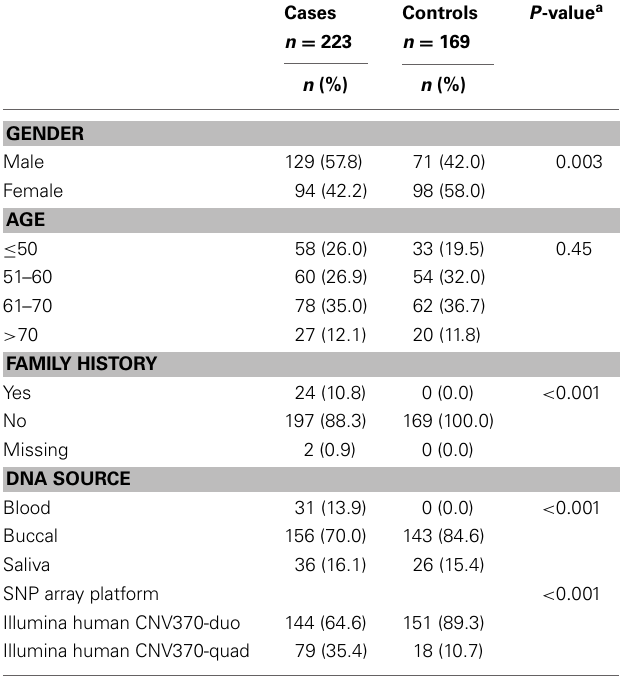
Table 2 | Characteristics of the CNV discovery samples.